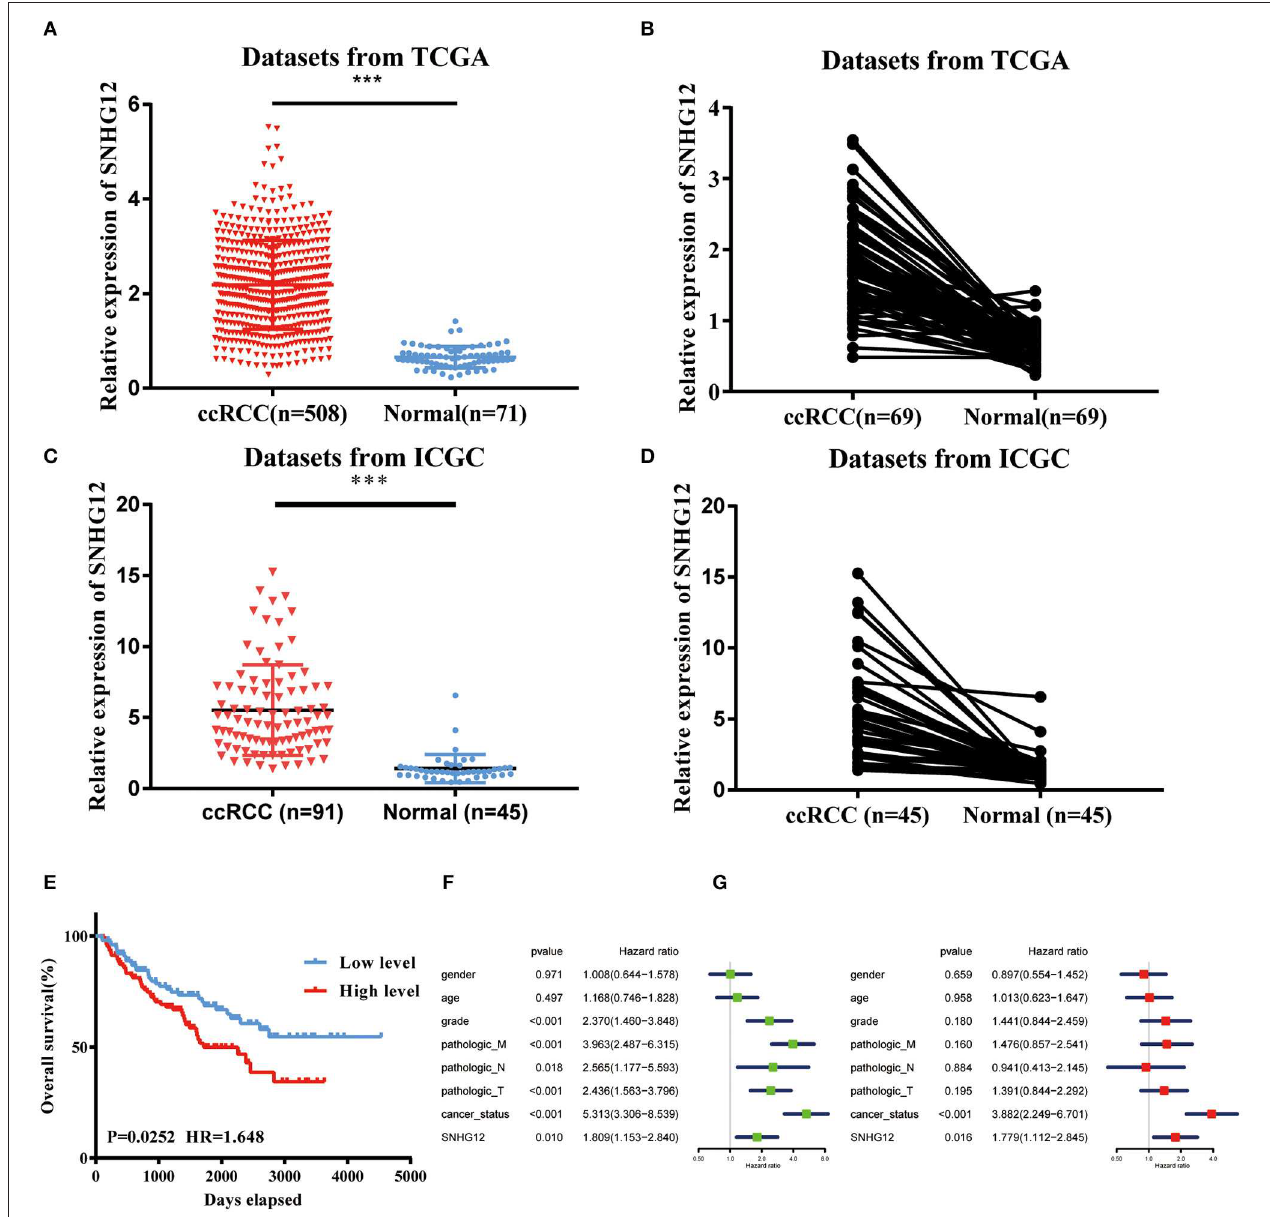
FIGURE 1 | SNHG12 was upregulated in ccRCC tissues. (A) Relative expression of SNHG12 in ccRCC tissues compared with normal tissues was analyzed using TCGA data. (B) Relative expression of SNHG12 in 69 pairs matched ccRCC tissues and normal tissues in TCGA data. (C) Relative expression of SNHG12 in ccRCC tissues compared with normal tissues was analyzed using IGCA data. (D) Relative expression of SNHG12 in 45 pairs matched ccRCC tissues and normal tissues in TCGA data. (E) Kaplan-Meier survival curves according to SNHG12 expression levels in TCGA data.Univariate (F) and multivariate (G) Cox regression analysis of clinical parameters and SNHG12 in TCGA database of ccRCC patients. Clinical variables included gender (Female vs. Male), age ( < 60 vs. > = 60), grade (G1 + G2 vs. G3 + G4), pathologic_M (M0 vs. M1), pathologic_N (N0 vs. N1), pathologic_T (T1 + T2 vs. T3 + T4), cancer_status (Tumor free vs. With tumor) and SNHG12 (Low level vs. High level). Error bars stand for the mean ± SD of at least triplicate experiments. *** P <